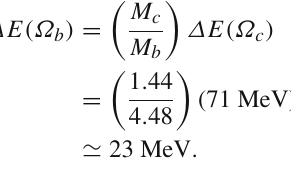
two lowest 1 S states, the Ω b ( 1 / 2 + ) at 6046 . 1 ± 1 . 7